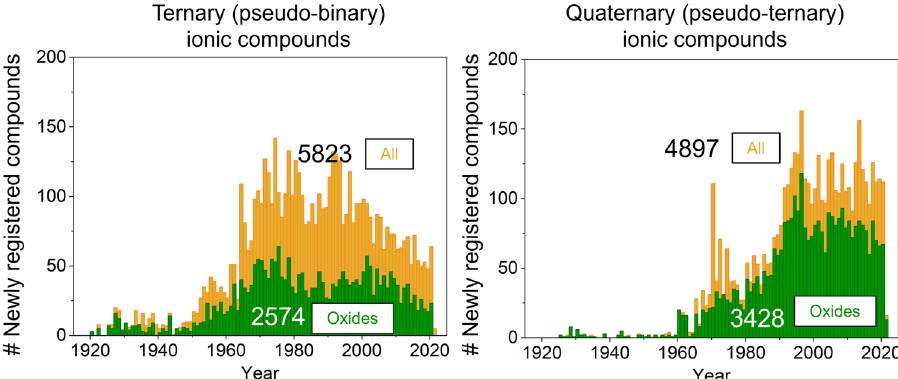
Fig. 1 The yearly trend of the number of unique compositions registered in ICSD (2021 Ver.2) for ternary and quaternary ionic compounds (orange bars). Only compounds reported to be experimentally synthesized, satisfying the charge-neutral condition, and having no partially occupied sites were adopted. Oxides are shown separately by green bars. Data-extraction procedures from ICSD to construct these fi gures are given in the Supplementary